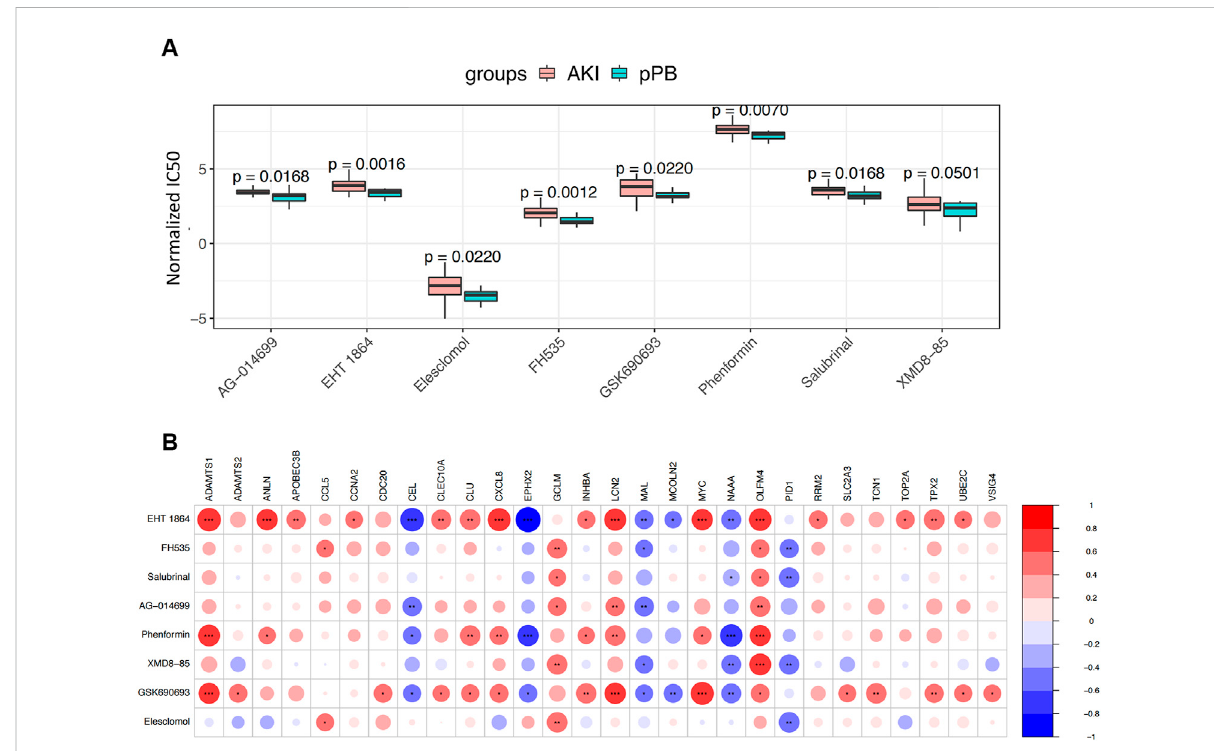
FIGURE 8 Drug Predict analysis. (A) Comparison of the sensitivity of screening drugs in different groups. (B) Screening for correlation analysis between drug sensitivity and ferroptosis genes; blue and red represent positive and negative correlations, respectively.